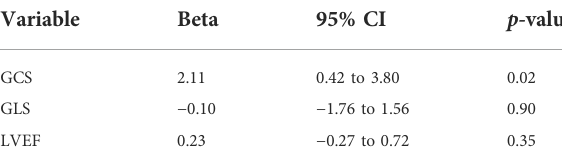
TABLE 3 Multivariable linear regression analysis for LGE